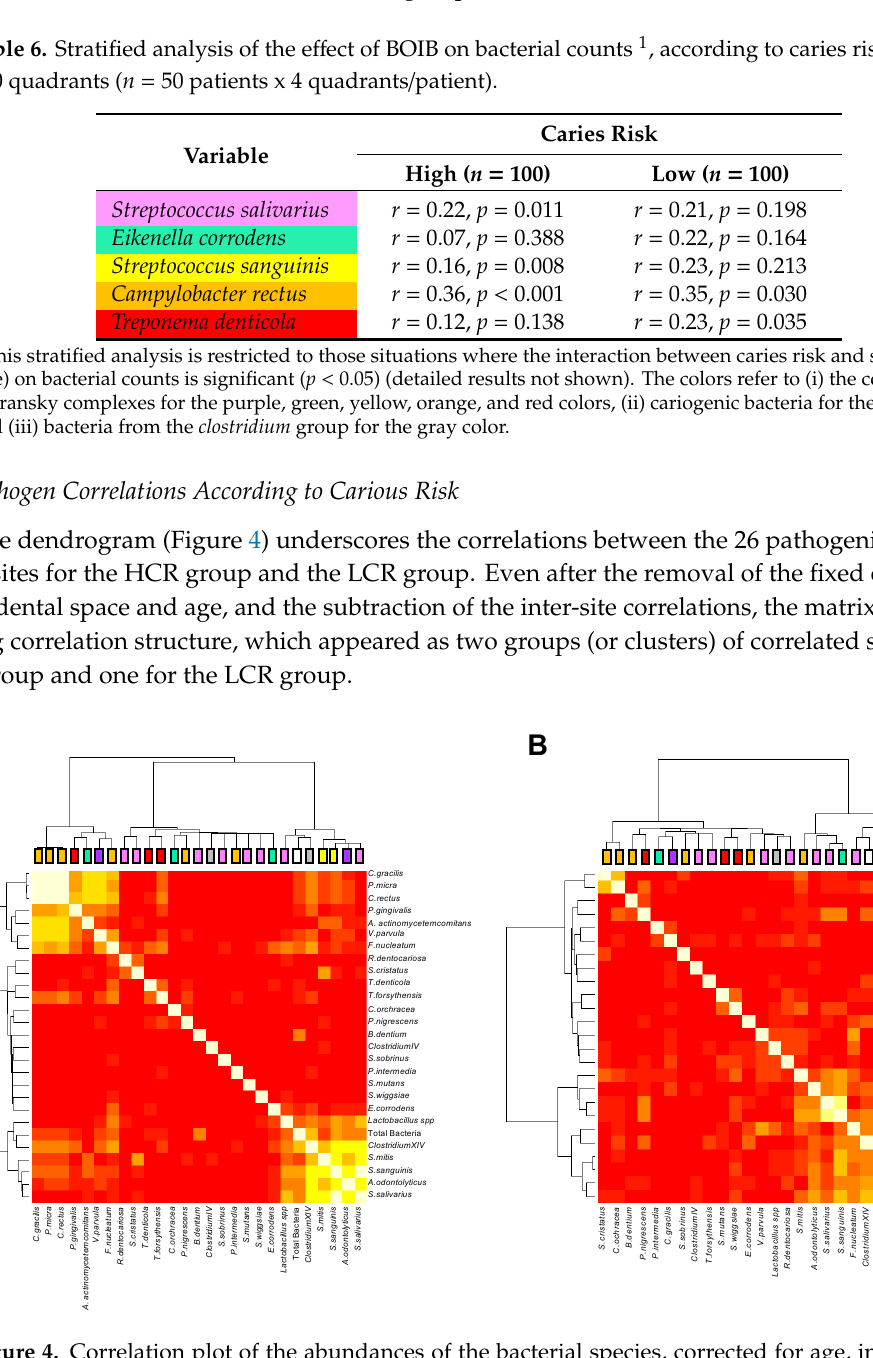
Figure 4. Correlation plot of the abundances of the bacterial species, corrected for age, interdental space and individual-specific effects. ( A ) High caries risk group, ( B ) low caries risk group. Yellow indicates positive correlations, whereas red indicates the absence of correlations. The colored leaves on the top dendrogram represent (i) the colors of the Socransky complexes for the purple, green, yellow, orange, and red colors, (ii) cariogenic bacteria for the pink color and (iii) bacteria from the clostridium group for the gray color.